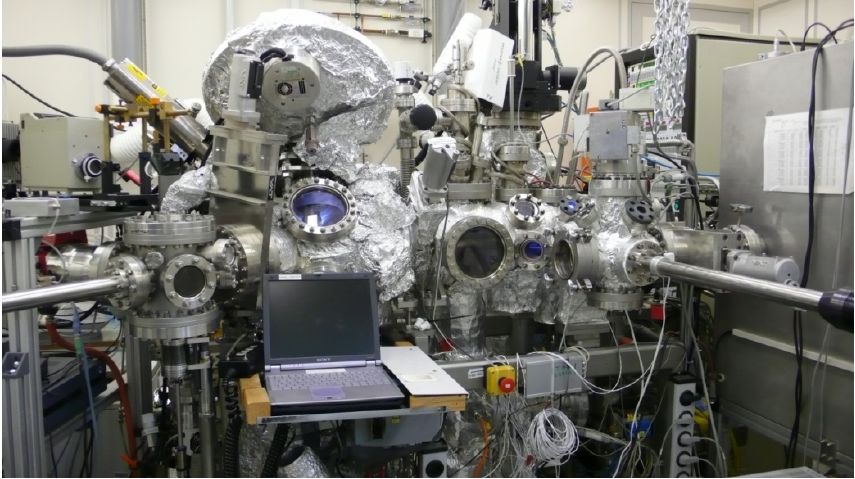
Figure 1: View of the CISSY station in the laboratory (glove box partly visible on the right